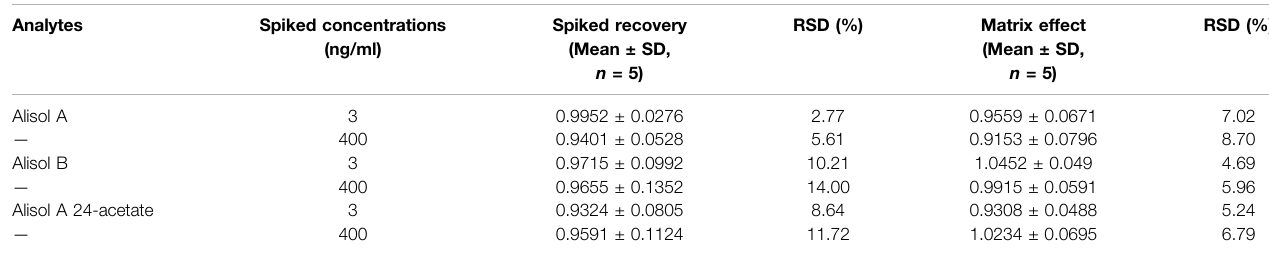
TABLE 5 | Spiked recovery and matrix effect of the three analytes.